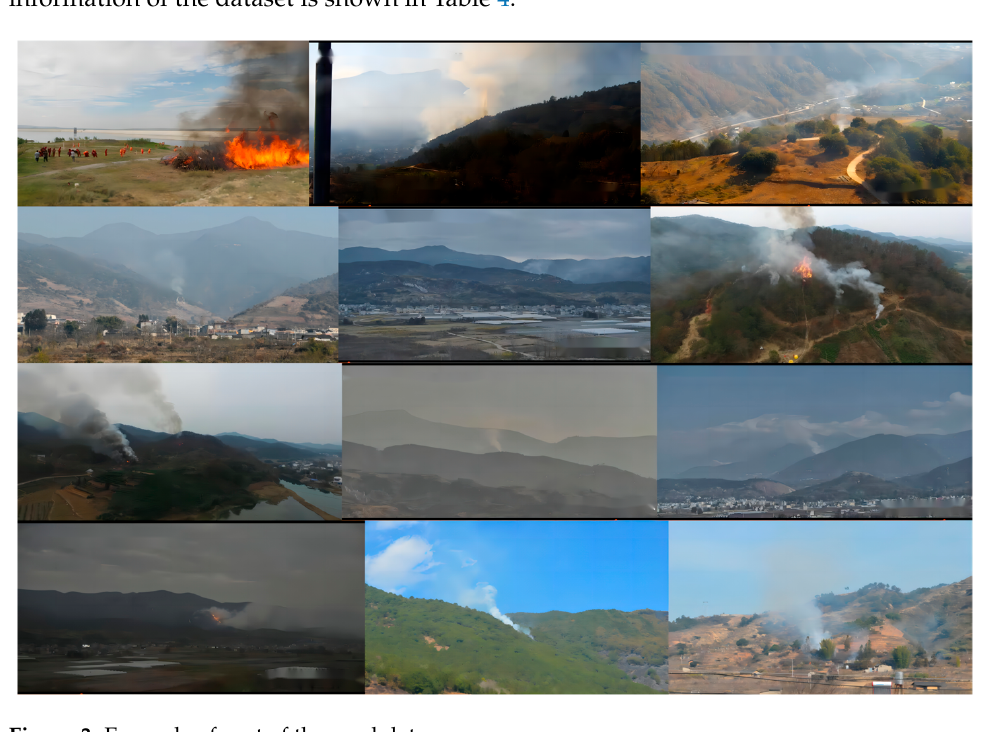
Table 4. Forest fire dataset.